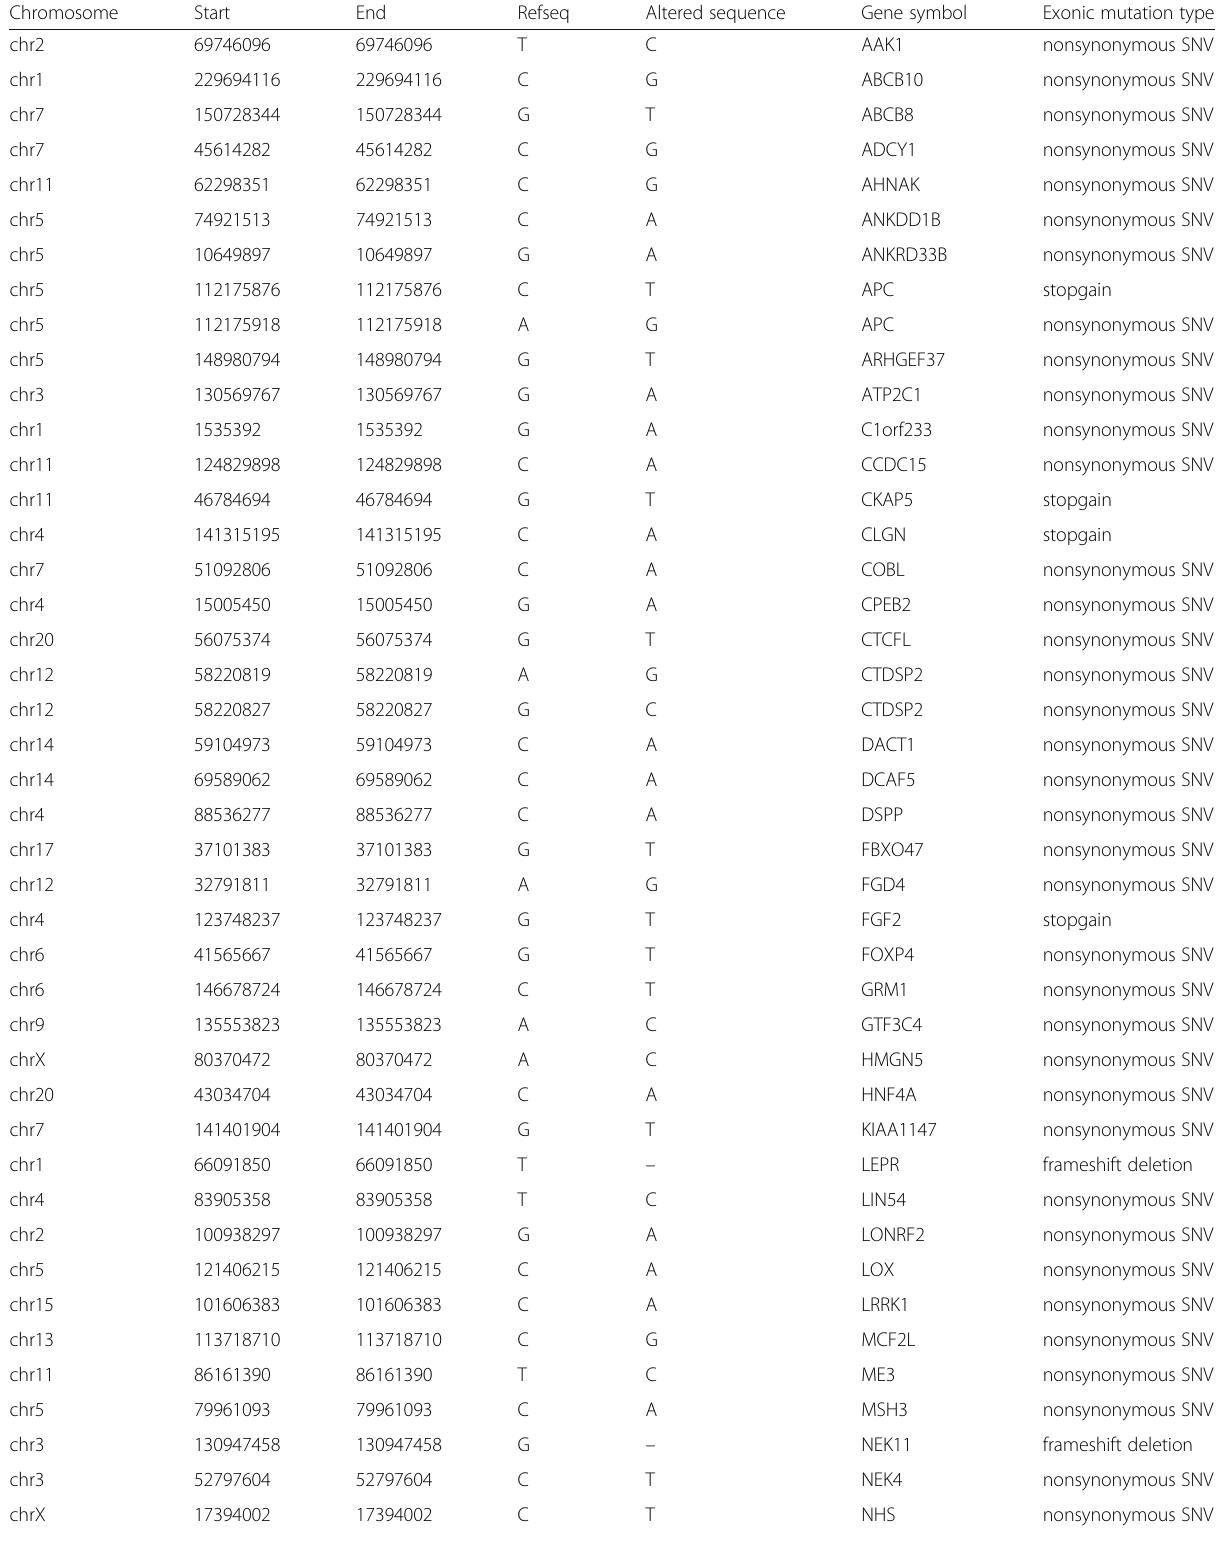
Table 1 Detected nonsynonymous variants in the patient revealed by candidate gene sequencing and confirmed by Sanger